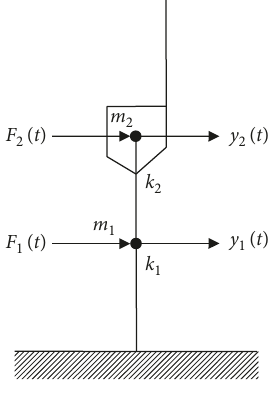
Figure 13: Structural vibration computational mechanical model of the high side wall in the underground